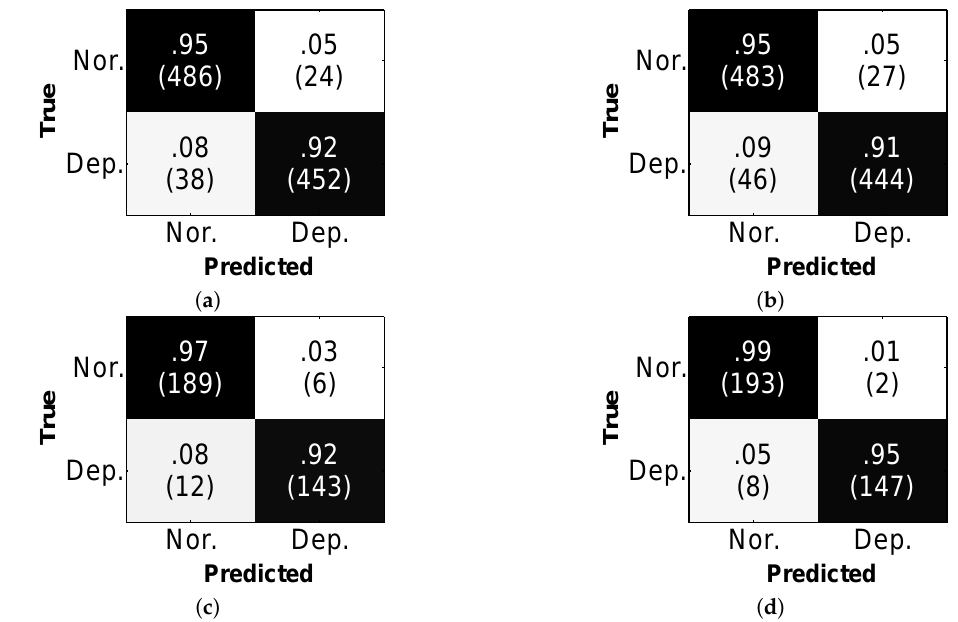
Figure 6. The confusion matrices of the proposed ( a ) TCC-softmax on DAIC-WOZ, ( b ) TCC-kernel on DAIC-WOZ, ( c ) TCC-softmax on MODMA, and ( d ) TCC-kernel on MODMA for the normal (noted as ‘Nor.’) and depression (noted as ‘Dep.’)